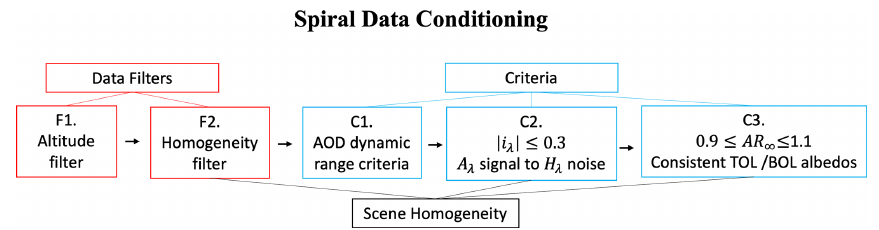
Figure 1. Data conditioning flowchart. First, the data are filtered vertically (i.e., data are removed) to (F1) isolate the aerosol layer only and (F2) isolate either cloudy- or clear-sky data such that the profile represents a homogeneous sky type. Once filtered, the data must pass three distinct criteria to ensure that (C1) the full aerosol layer is captured, (C2) the effect of aerosol absorption on radiative fluxes is much greater than that due to horizontal variability present, and (C3) the top-of-layer (TOL) and bottom-of-layer (BOL) albedos are mutually